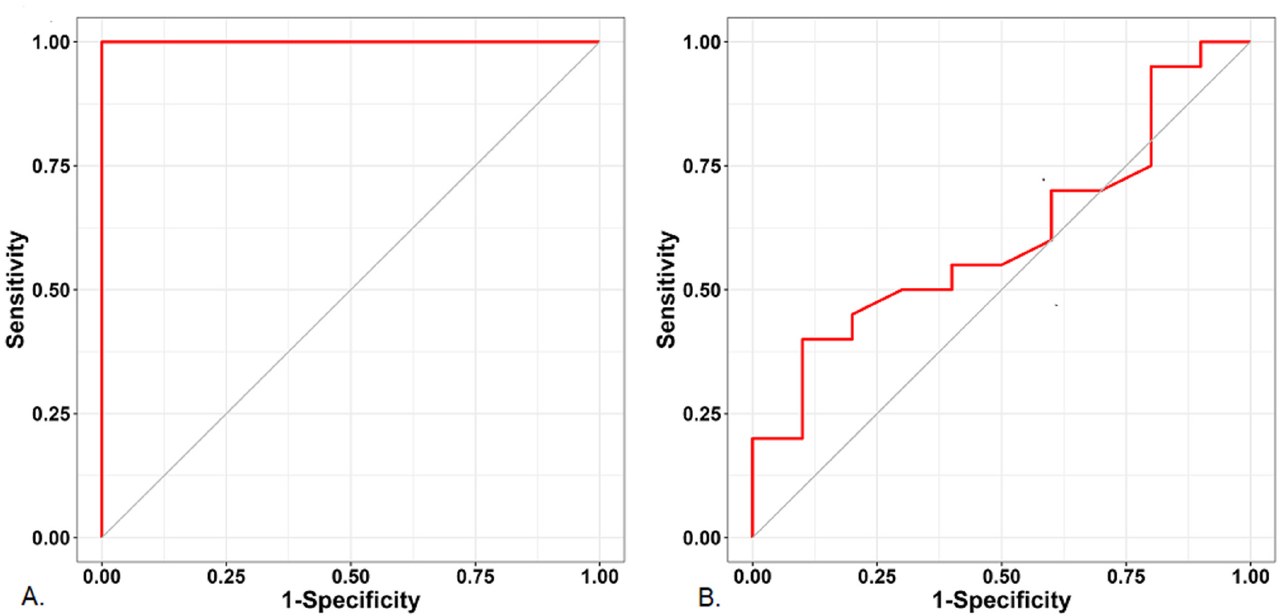
Figure 3. Comparing the receiver operating characteristic curves of the perfusion indices of the ( A ) ear and ( B ) finger.